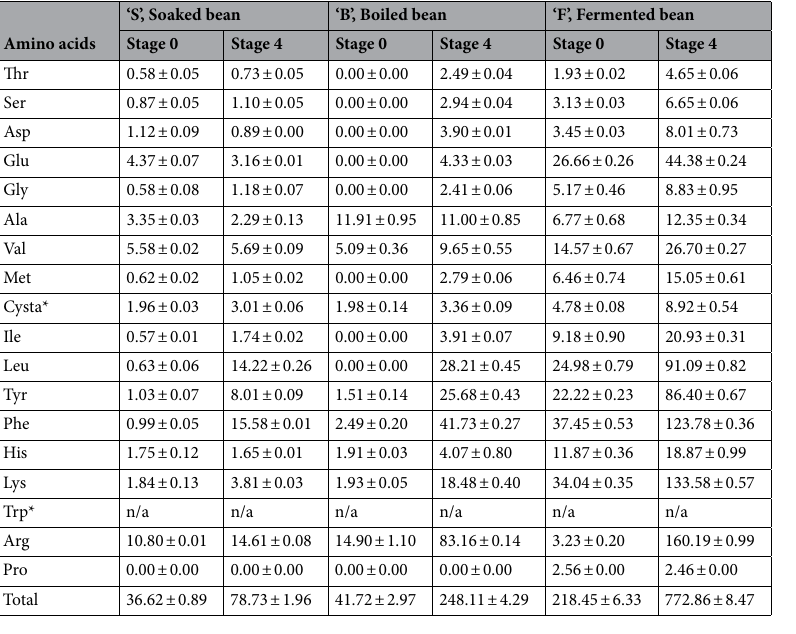
Table 1. Changes in free amino acid content in soaked, boiled, and fermented soybeans by simulated digestion. Each value represents the mean of three replications ± standard deviation. *Cysteine (Cys) was determined in the form of cystathionine (Cysta). Tryptophan (Trp) cannot be reported because it is unstable and produces ammonia, so it was not obtained in the amino acid standard